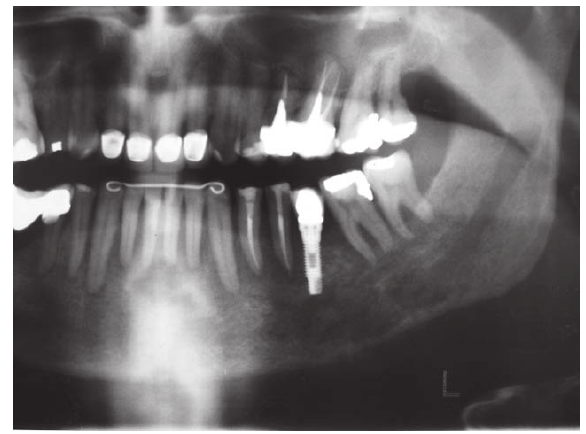
Figure 2- Panoramic radiography showing diffuse radiolucent area in the left mandibular body